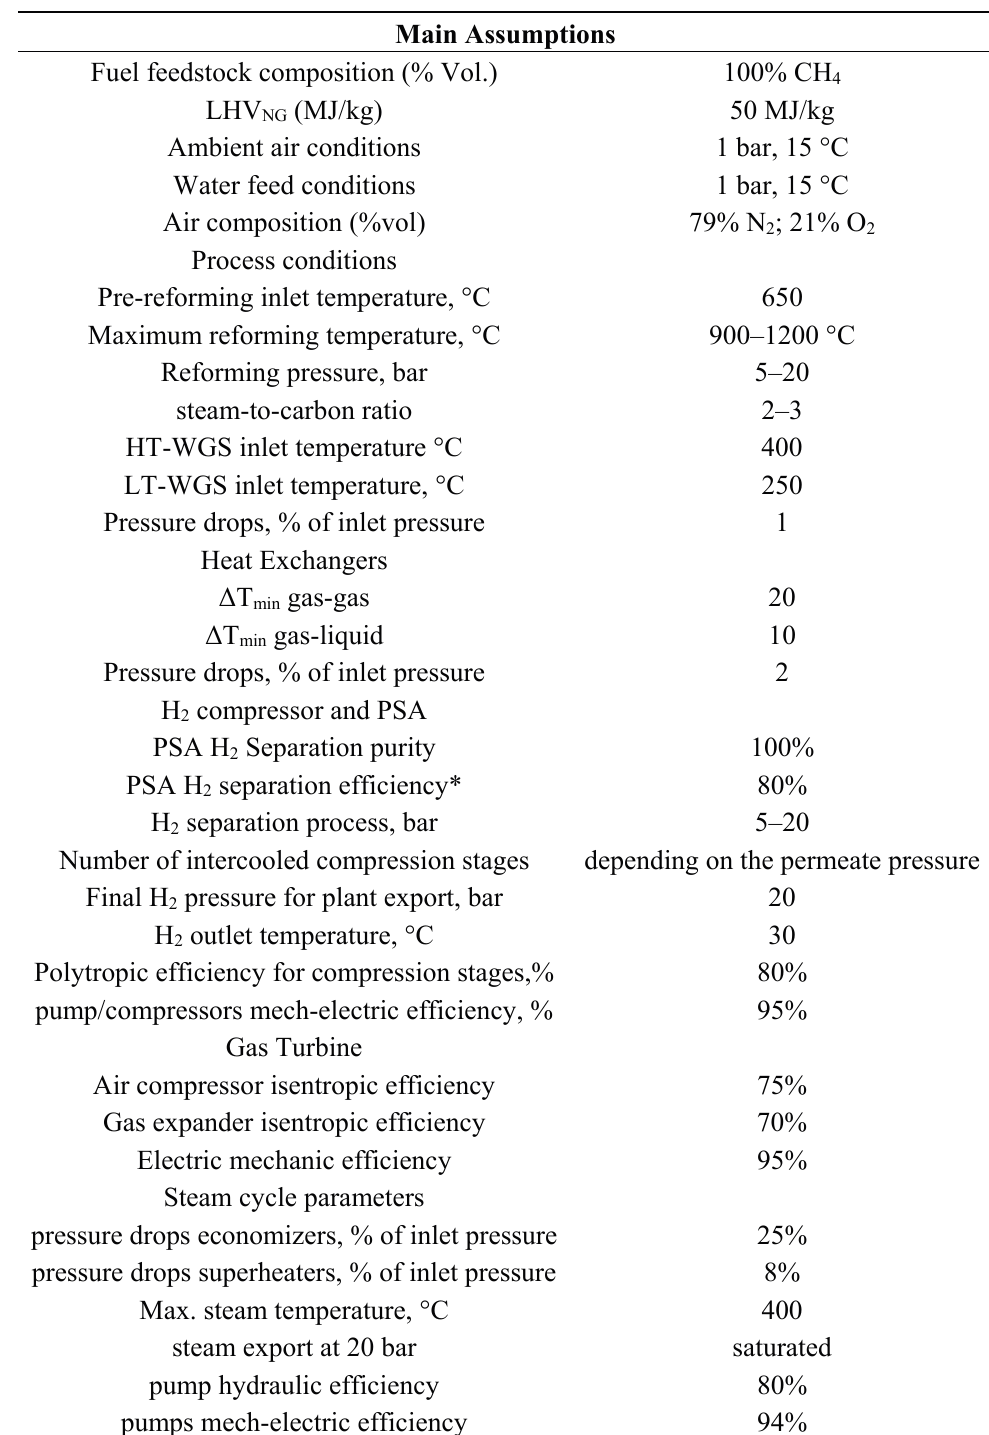
Table 4. List of assumptions used in the